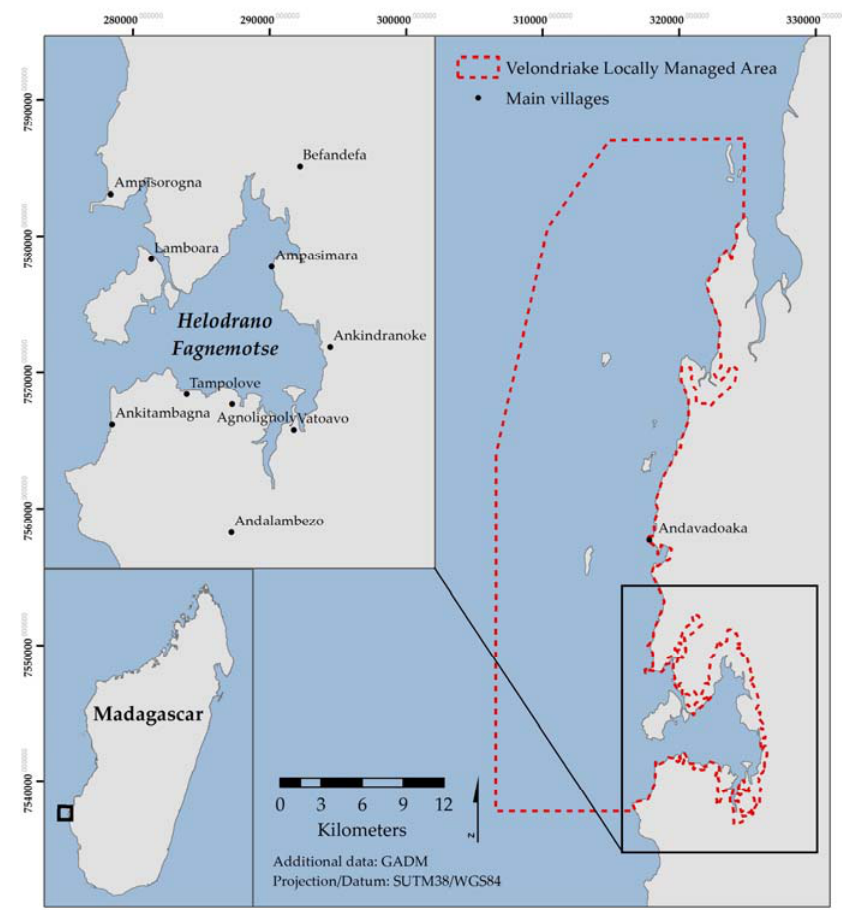
Figure 1. The location of the study area—Helodrano Fagnemotse—in the southwest of Madagascar as well as the main villages within the bay and the its location within the Velondriake Locally Managed Marine Area (LMMA).